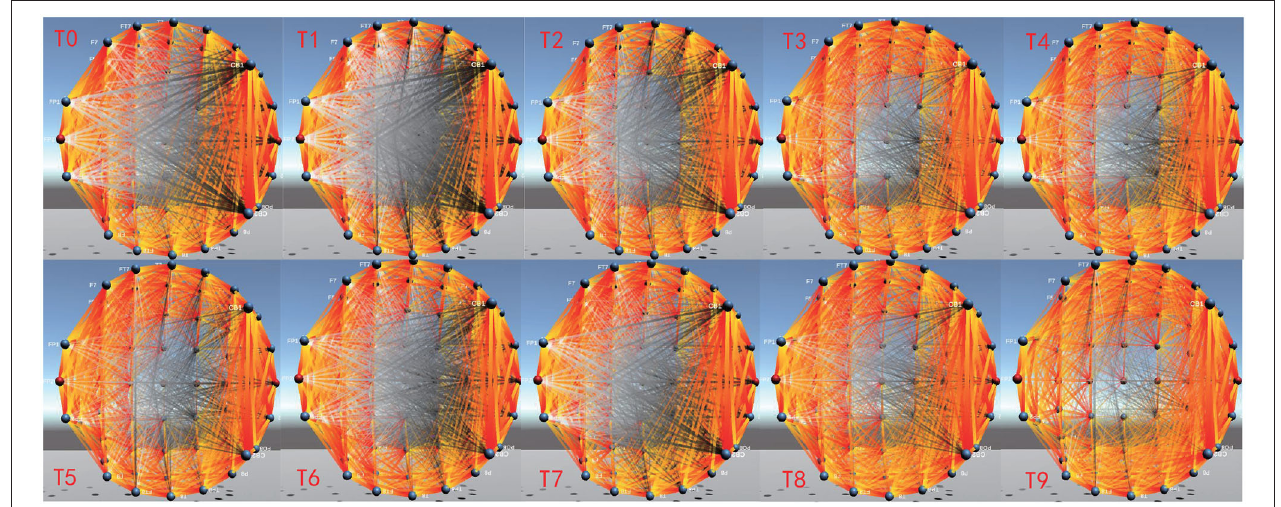
FIGURE 10 | Dynamic visualization changes over time.